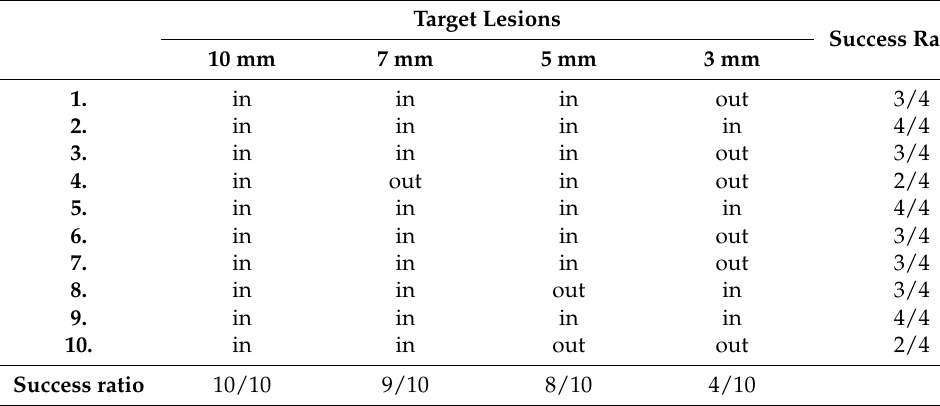
Table 2. Success rate for all the participants involved in the